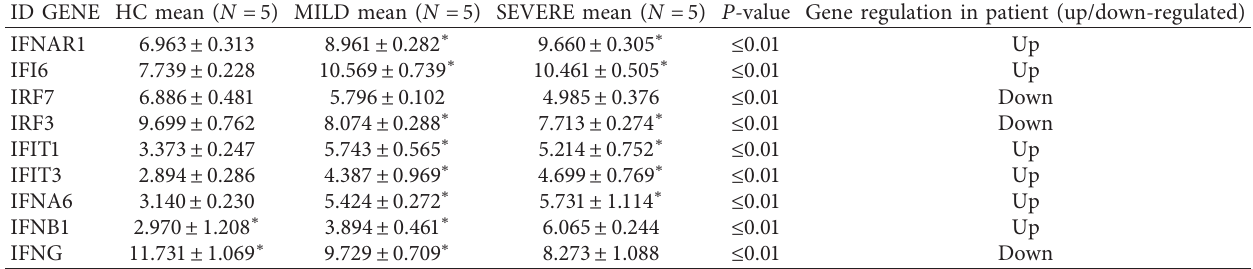
Table 4: The expression level of healthy control, mild, and severe COVID-19 patients. Note: Values marked with an asterisk are not significantly different ( p > 0 . 05 )